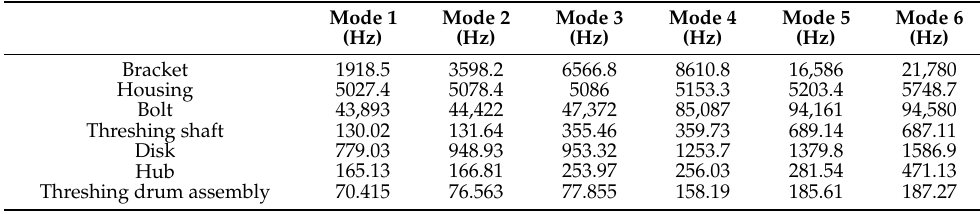
Table 5. Eigenvalues of the bracket and